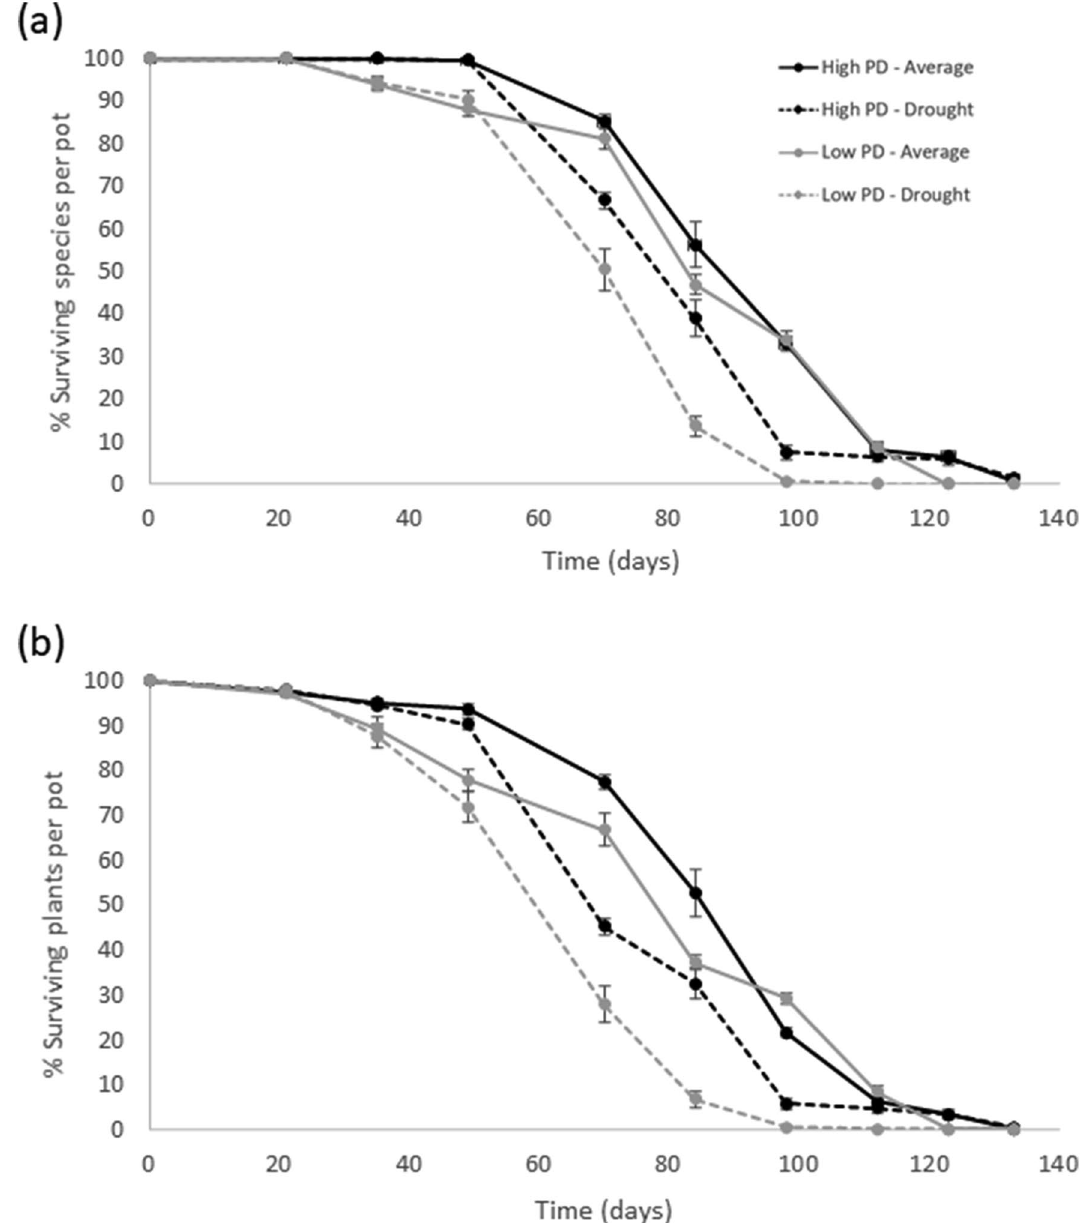
Figure 4. ( a ) Percent of surviving species per pot and ( b ) percent of surviving plants per pot on each sampling date (see Table 2). Black lines represent high phylogenetic diversity (PD) scenarios and grey lines denote low phylogenetic diversity scenarios. Solid lines represent the average precipitation treatments based on natural precipitation for 30 years, and spotted lines denote drought treatments (33% of the average precipitation). Vertical bars represent the standard